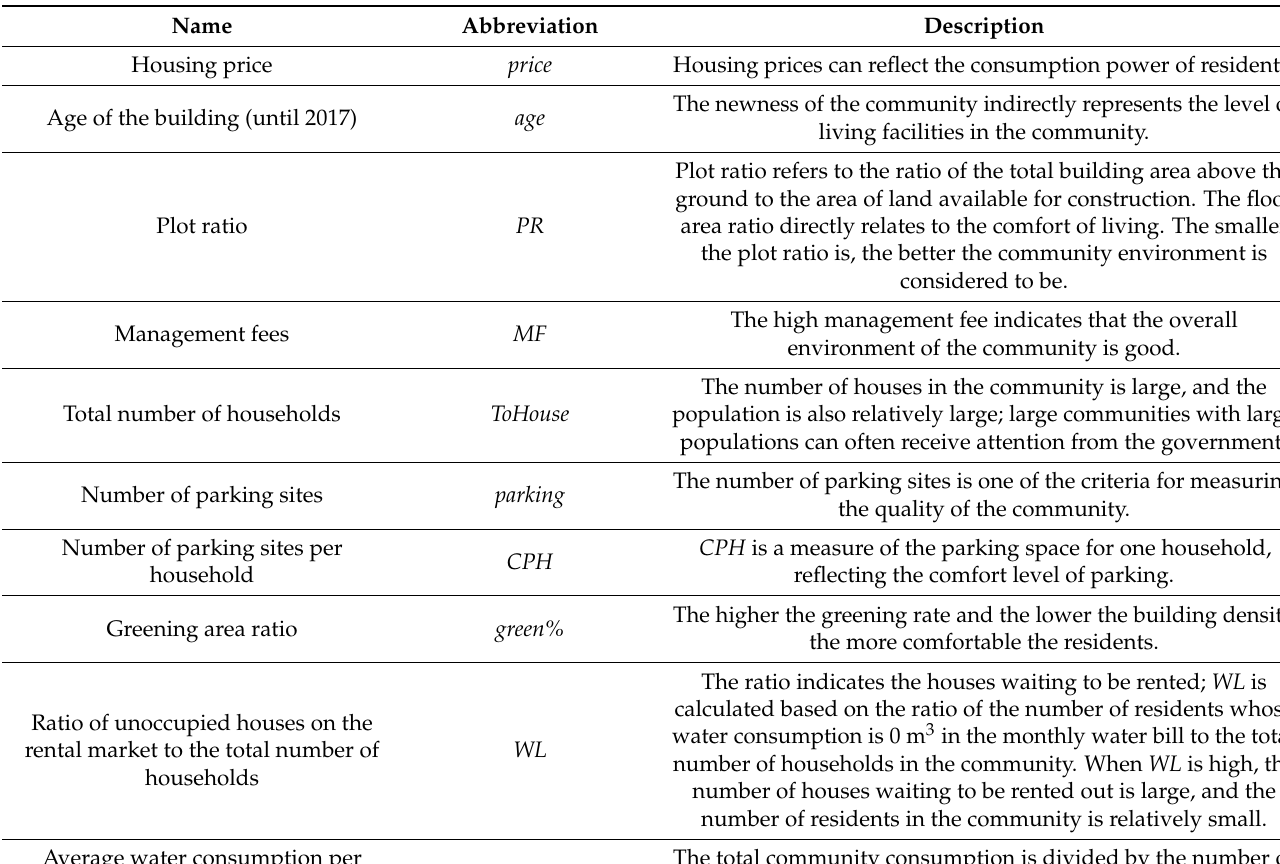
Figure 1. Spatial distribution of the 14 investigated communities in Shanghai. Table 1. Abbreviations and descriptions of 10